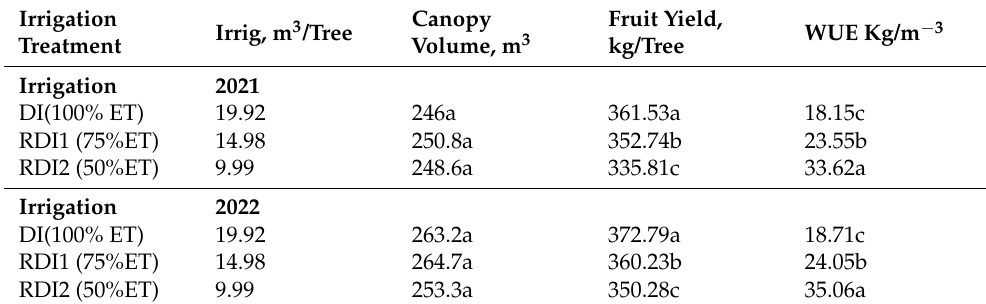
Table 8. Mature tree average fruit yield, water applied, canopy volume and WUE for each irrigation treatment during 2021 and 2022.